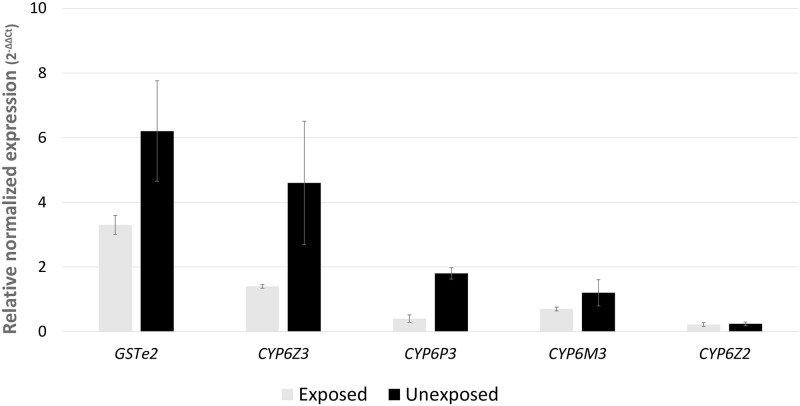
Determination of molecular basis of pyrethroid resistance in the An. coluzzii population.Results of transcription profiling of 5 major insecticide resistance gene using qRT-PCR. Values are represented as mean of expression in relation to Ngousso ± SD.